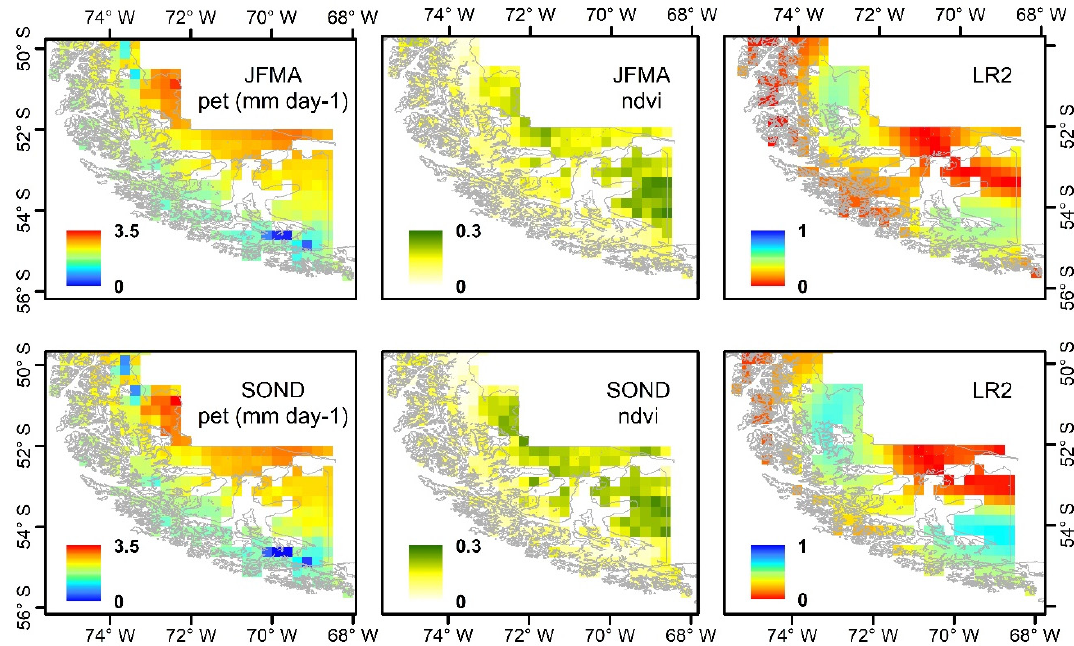
Figure 5. Spatial patterns of potential evapotranspiration (left-hand plots), NDVI (center plots) and explained variance of the regression between potential evapotranspiration and NDVI values from 1985–2018 (right-hand plots). JFMA = January to April, SOND = September to December, LR2 = local squared regression coefficient.